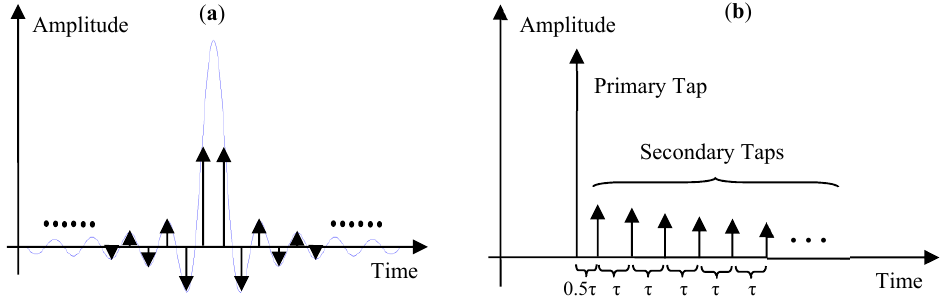
Figure 3. ( a ) The Sinc function distribution impulse response and ( b ) primary and secondary tap distribution impulse response microwave photonic notch filter.